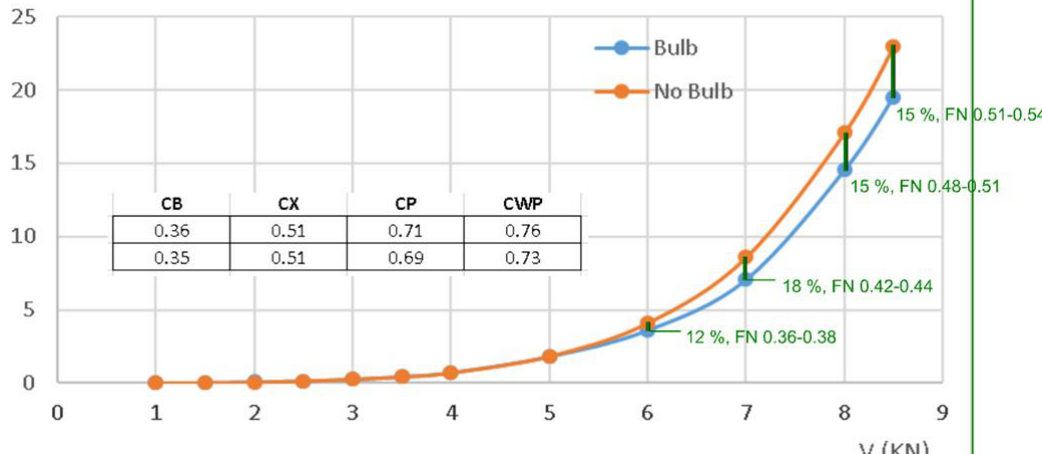
Figure 21. Power reduction for FAO3 vs. FAO4, light conditions.